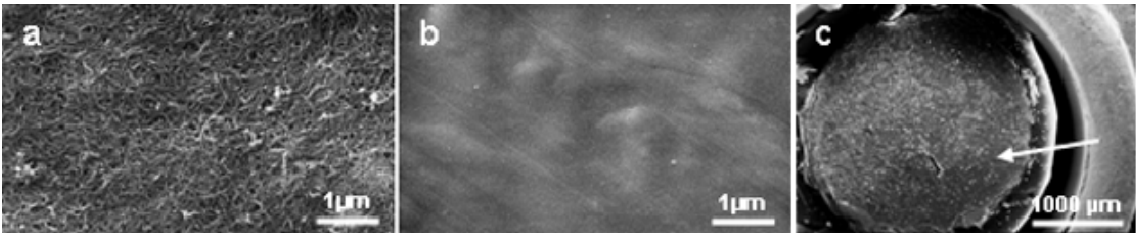
Figure 1. Rough - and smooth surfaces for cell cultivation. (a) carbon (C) nanotubes surface. (b) high density polyethylene (PE)-surface. (c) C-nanotubes (arrow) mounted on the bottom of the wells of the PE-microsubstrate for cell